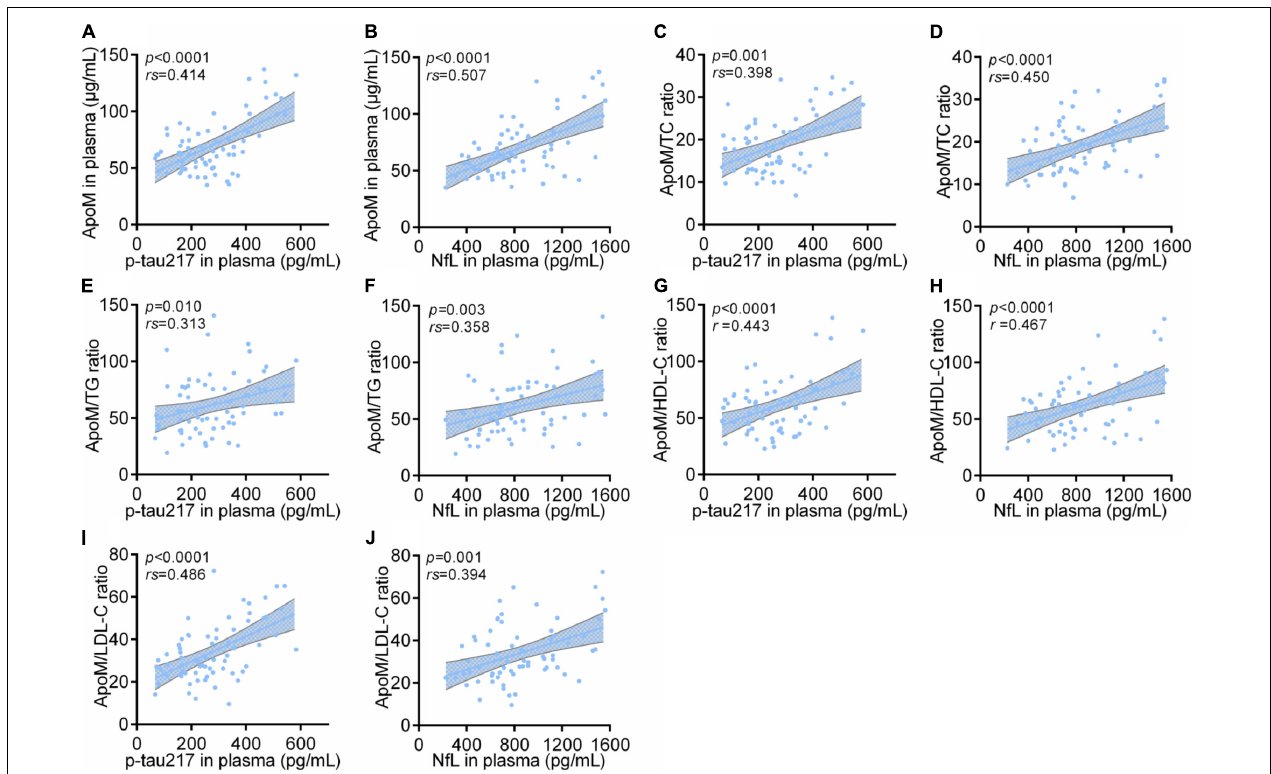
FIGURE 5 | Correlations between plasma ApoM and its derived indicators with representative blood biomarkers of AD in AD group. ApoM, apolipoprotein M; p-tau217, tau phosphorylated at threonine 217; NfL, neurofilament light chain; CN, cognitively normal; AD, Alzheimer’s disease; TC, total cholesterol; TG, triglyceride; HDL-C, high-density lipoprotein cholesterol; LDL-C, low-density lipoprotein cholesterol. Correlation analyses were performed using Spearman’s rank correlation (A–F,I,J) or Pearson’s correlation (G,H) as appropriate. p < 0.05 was considered the statistical significance.